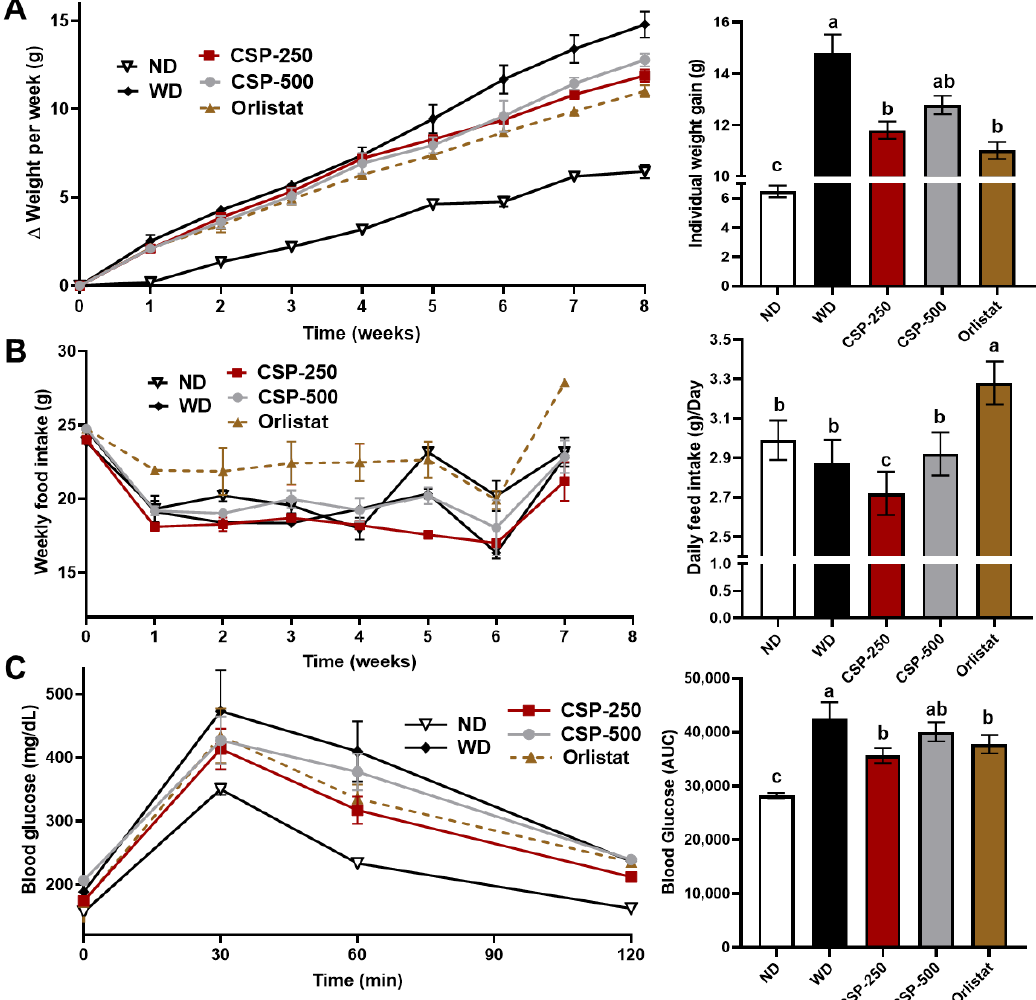
Figure 1. Effect of canary seed peptides (CSP) oral administration over body weight ( A ); weekly and daily feed intake ( B ); and intraperitoneal glucose tolerance in Western diet induced obese C57BL/6J mice at the seventh week of the study and prior to a six-hour fasting period ( C ). ND, normal diet; WD, Western diet; CSP-250, mice supplemented with 250 mg/kg of body weight of CSP; CSP-500, mice supplemented with 500 mg/kg of body weight of CSP; Orlistat, mice supplemented with 40 mg/kg of body weight of orlistat. Bars and lines represent mean values ± SEM ( n = 8 per treatment). Different letters (a – c) indicate statistical differences ( p < 0.05) between treatments.